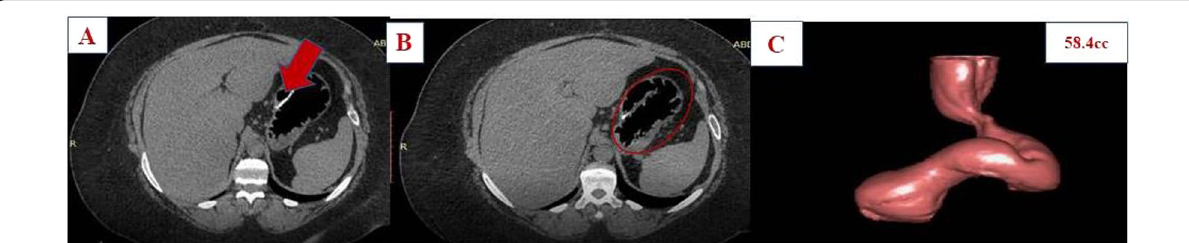
Fig. 4 A 36‑year‑old obese female (BMI 37.5) with postoperative gastric volume is 58 cc. Preoperative weight and 1‑year postoperative weight = was 108 kg and 69 kg, respectively. Weight reduction percentage is 36.2%, and 1‑year postoperative BMI is 24.1. Although the postoperative gastric volume is low, the weight reduction percentage at 1 year is low compared to other patients with larger gastric volume but the % of loss from the excess weight after 1 year is 88.6%. A, B CT abdomen are showing staples (arrow) and gastric pouch (circle). C 3D CT gastric volumetry showing gastric volume of 58.4 cc